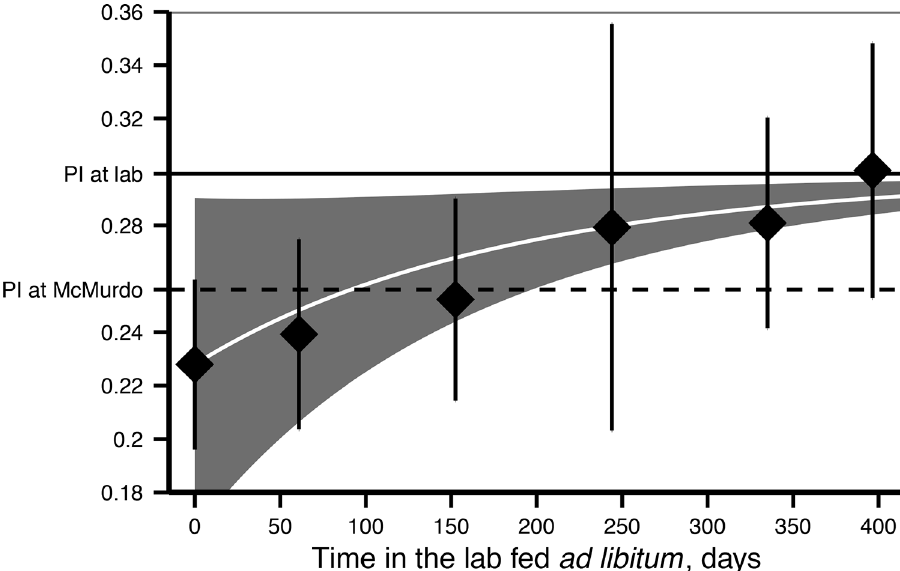
Fig 9. Pyloric Index (pyloric caeca weight / (total weight – gonad weight)) increment after the change in food availability (from the field to the laboratory). Points shows observed PI in the field at the moment of recollection (day 0) and the PI from individuals sampled in the laboratory experiment during the first year. Error bars are standard deviations. White line (mean) and shaded area (95% 95% confidence interval) are DEB model output for the PI, considering the DEB reserve dynamics after a change in food resources (S1 Appendix) applied to the animals used to obtain PI at day 0. Solid line: PI in the lab considering the reserves are in equilibrium with the available food (0.30, f = 1). Dashed line: PI for the available food estimated by the model for McMurdo (0.25, f f =